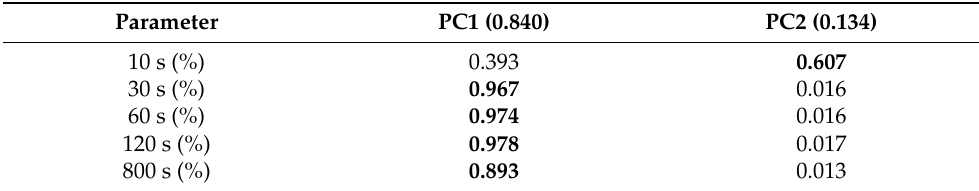
Table 9. Values of cos 2 for each parameter for the two axes of PCA restructuring test (the significant values are in